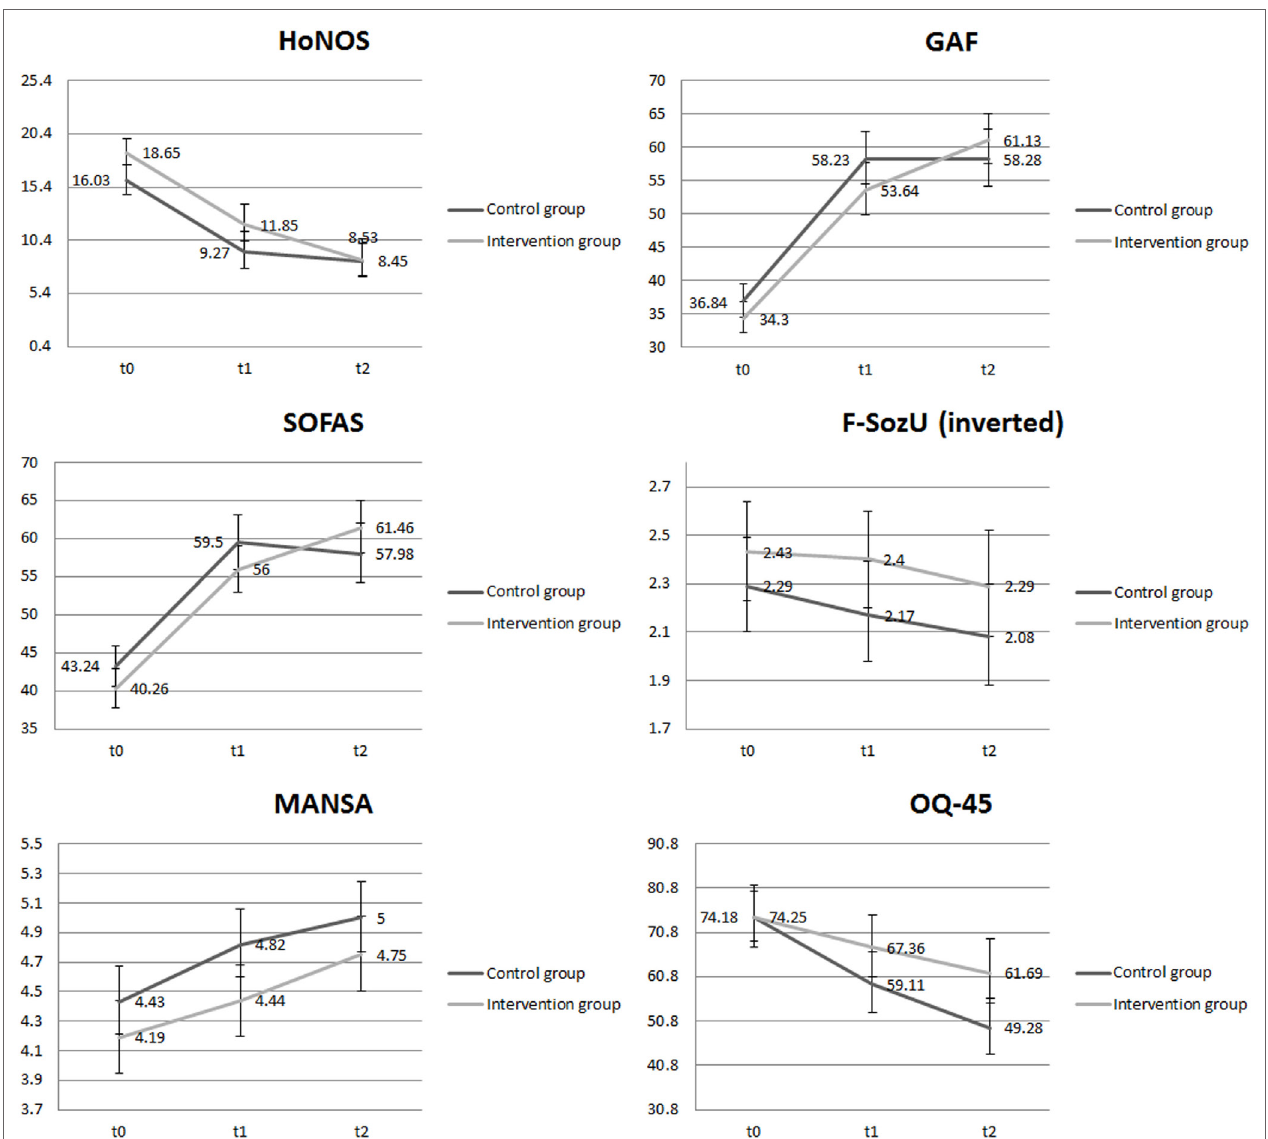
FiGUrE 2 | results of repeated outcome measures (secondary outcomes) . HoNOS, Health of the Nation Outcome Scales; GAF, Global Assessment of Functioning; SOFAS, Social and Occupational Assessment Scale; F-SozU (inv.), Fragebogen zur sozialen Unterstützung (inverted) [Social Support Questionnaire]; MANSA, Manchester Short Assessment of Quality of Life; OQ-45, Outcome Questionnaire